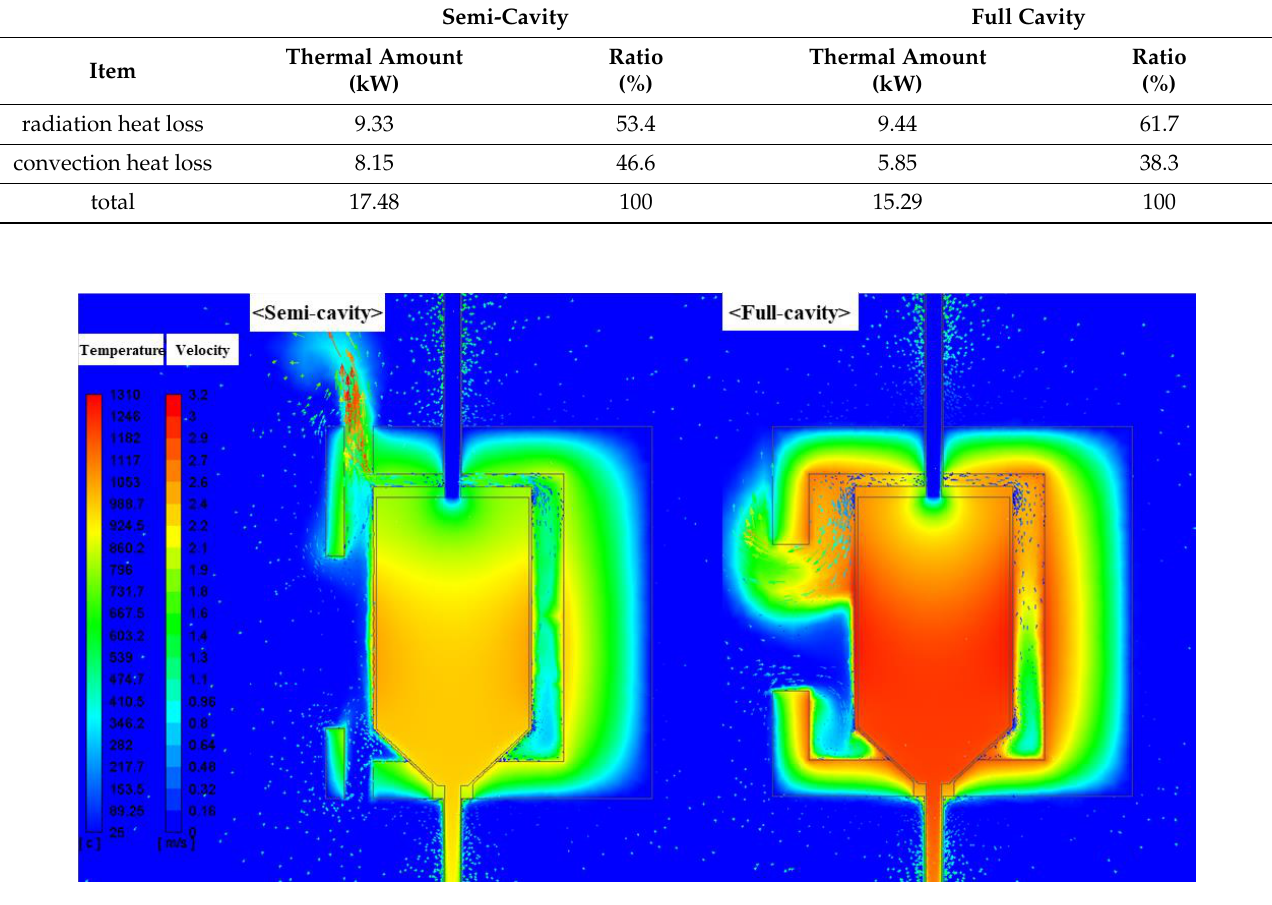
Figure 17. Temperature contour and air velocity vector distributions of center vertical cross-section of semi-cavity ( left ) and full cavity ( right ).